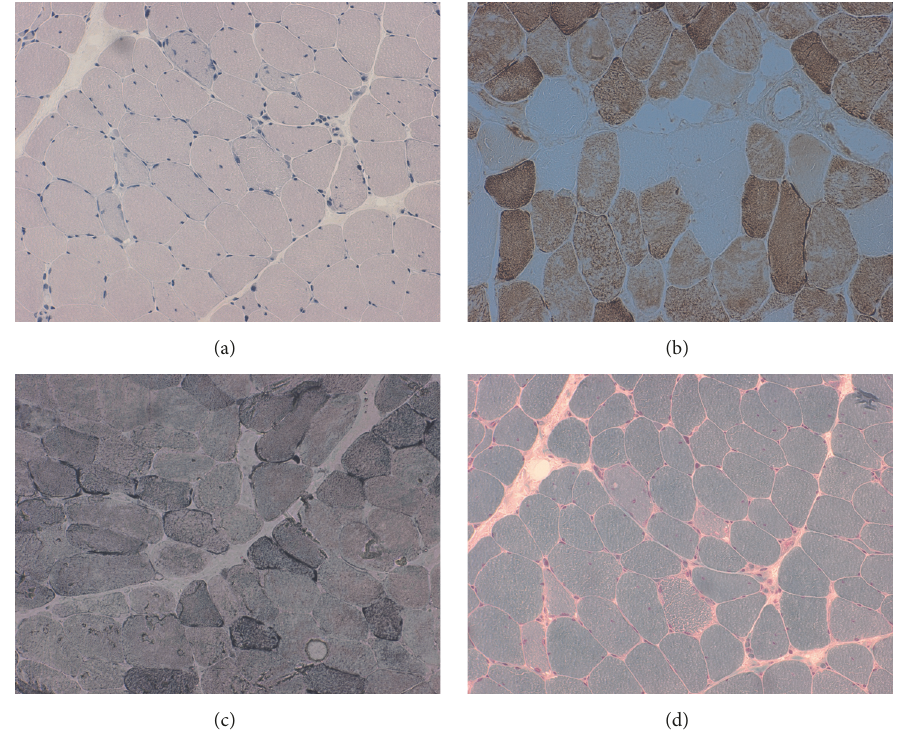
Figure1:Musclebiopsy:(a)hematoxylineosin;(b)stainingforcytochromeoxidase;(c)succinatedehydrogenase(SDH)staining;(d)G¨om¨ori trichrome stain.